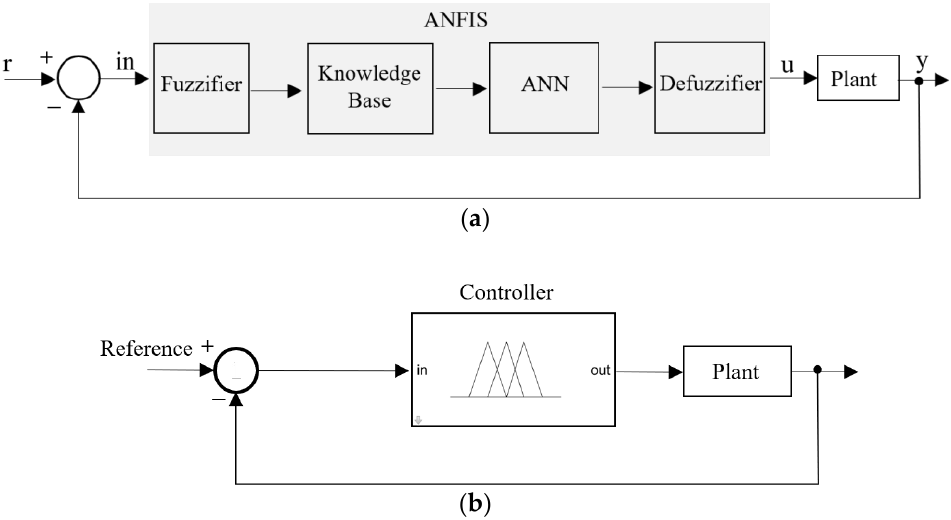
Figure 8. ANFIS architecture. ( a ) Diagram of the ANFIS controller. ( b ) Block diagram of the imple- mentation in Simulink. implementation in